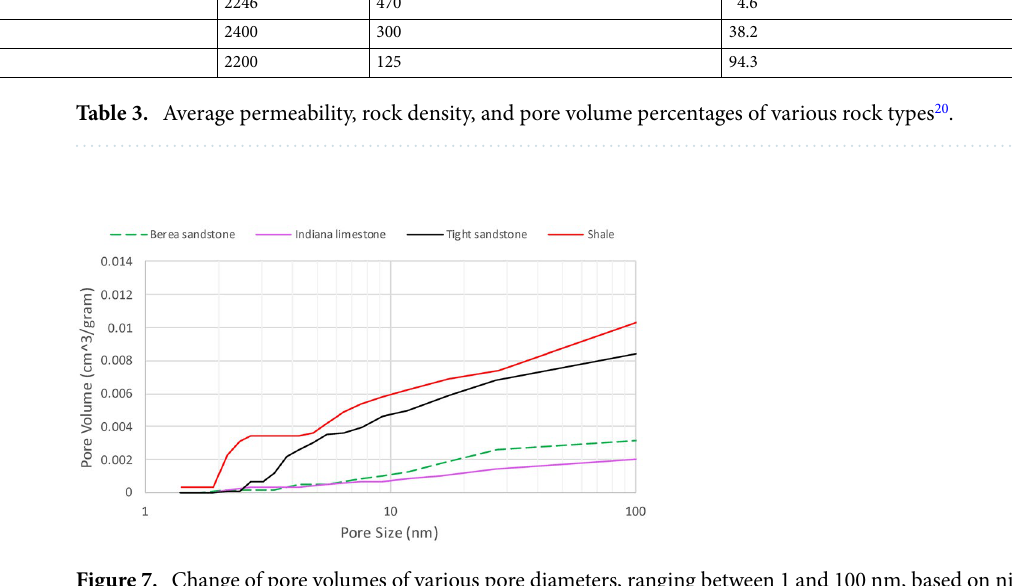
Figure 7. Change of pore volumes of various pore diameters, ranging between 1 and 100 nm, based on nitrogen desorption 20